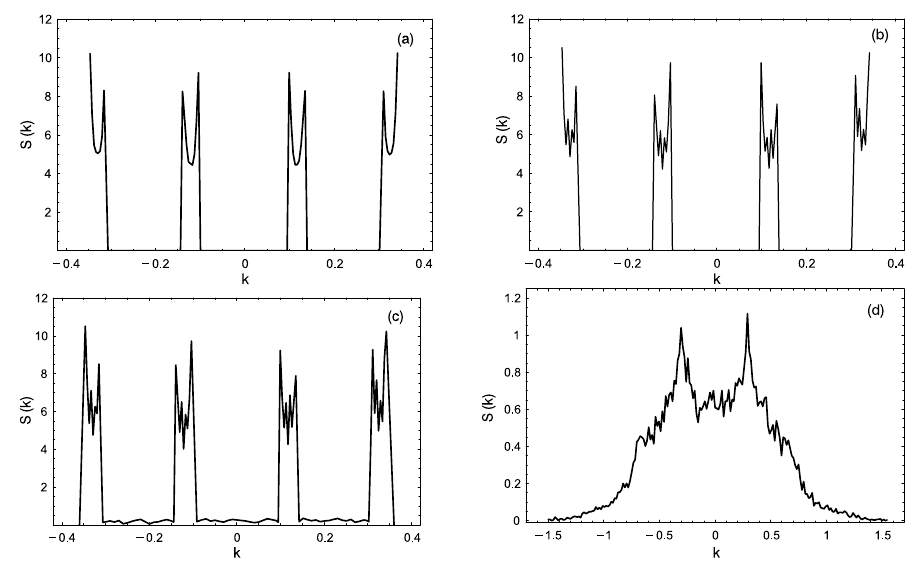
Fig. 10. Panel (a): the S ( k ) spectrum of a 3:4 resonant 3D orbit. Panels (b)–(d): the evolution of the S ( k ) spectrum of a sticky 3D orbit. See the text for details.